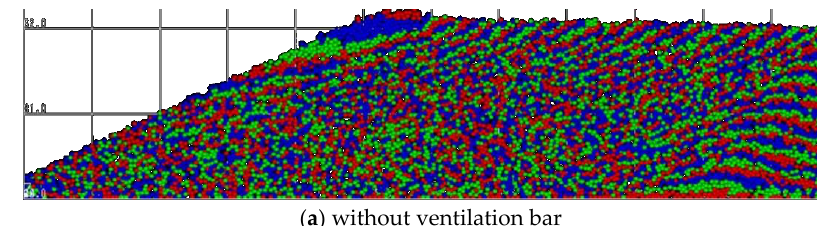
( a ) without ventilation bar Figure 4.